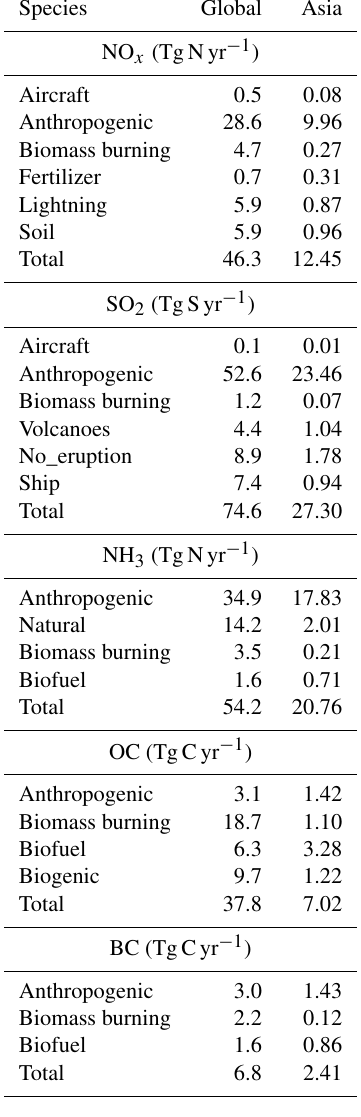
Table 1. Summary of annual emissions of aerosols and aerosol pre- cursors in Asia (60–155 ◦ E, 10–55 ◦ N).